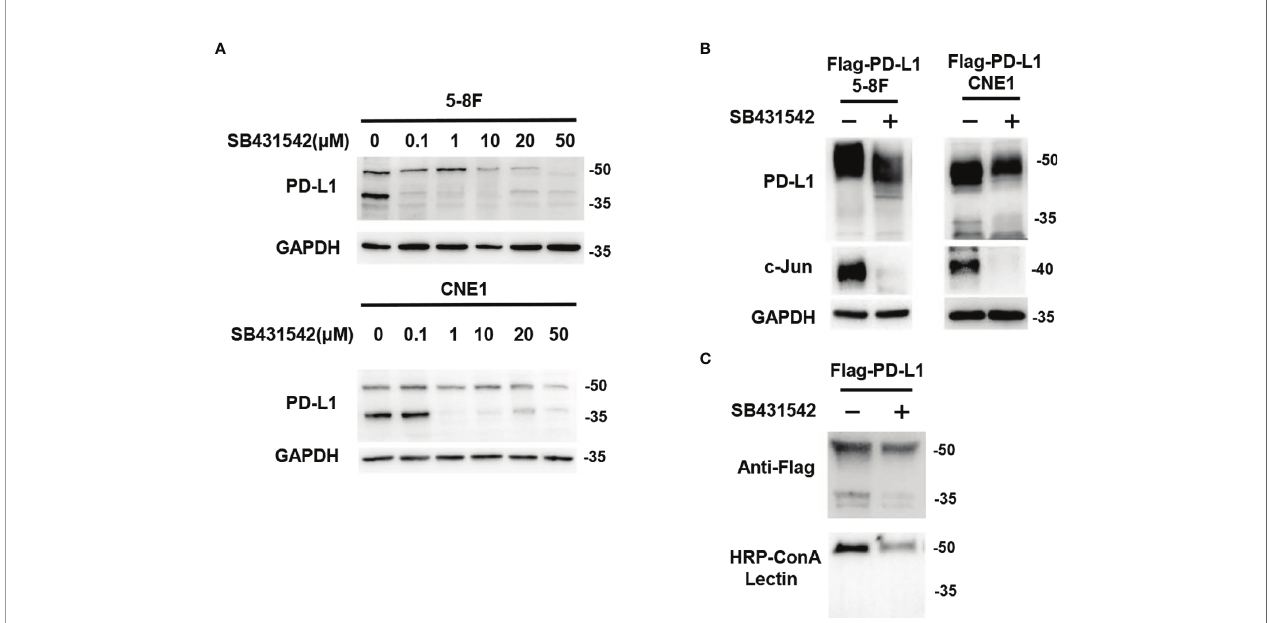
FIGURE 2 | Inhibition of TGF- b 1 by SB431542 Reduced PD-L1 Glycosylation in Vitro . (A) Western blot analysis of PD-L1 in 5-8F and CNE1 cells treated by SB431542 with increasing concentrations. (B) Western blot analysis of PD-L1 and c-Jun in exogenous Flag-PD-L1 expressing 5-8F and CNE1 cells with the treatment of 20 m M SB431542. (C) The glycosylation status of PD-L1 protein puri fi ed from SB431542 treating cells was analyzed by ConA lectin binding assay.